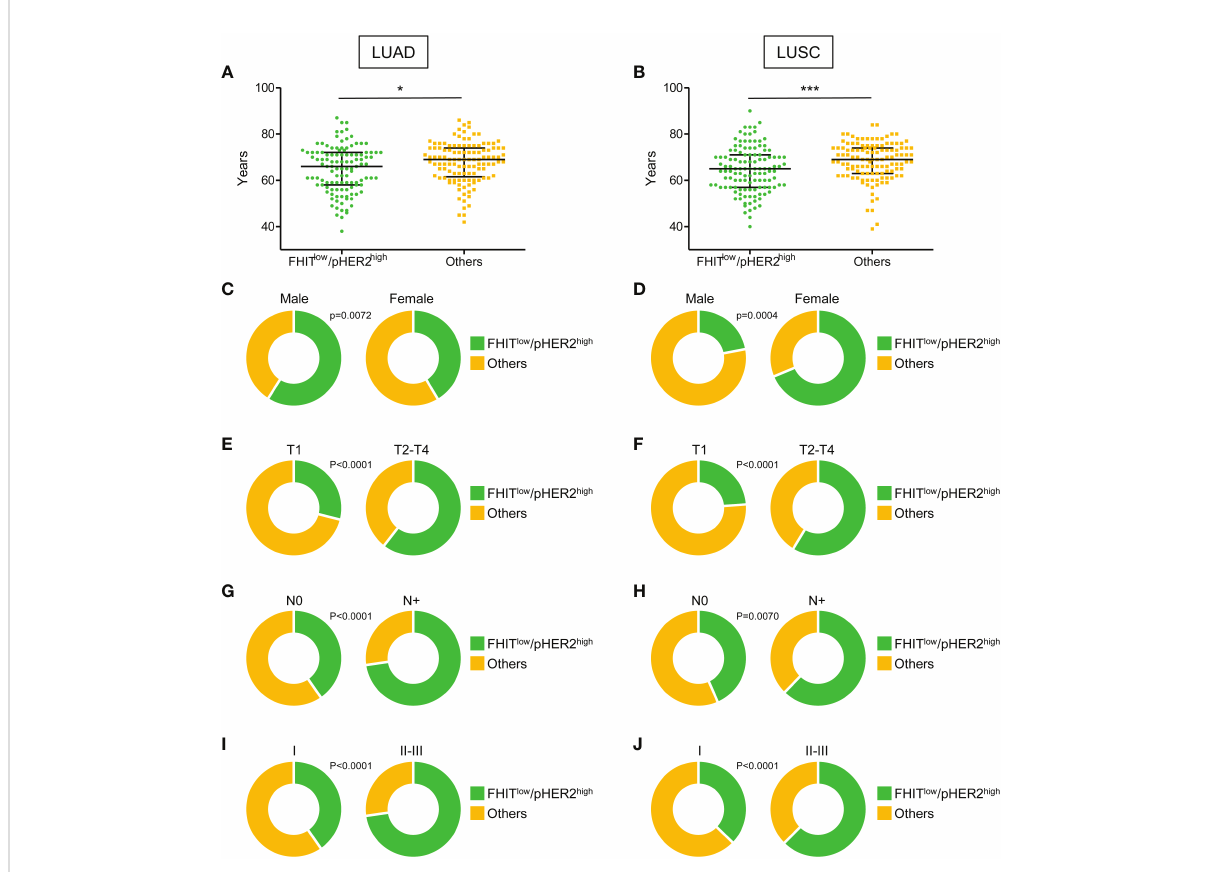
FIGURE 3 Clinical parameters associated with FHIT low /pHER2 high signature in Firehose Legacy TCGA-LUAD and TCGA-LUSC cohorts. (A, B) Distribution of the age of FHIT low /pHER2 high (in green) and other patients (in yellow) in LUAD (A) and LUSC (B) from a two-tailed Mann Whitney test. The median with 1 rst and 3 rd quartiles are shown in black. *p < 0.05; ***p < 0.001. (C-J) Distribution of the sex (C, D) , tumor size (T part of the TNM score) (E, F) , lymph node involvement (N part of the TNM score) (G, H) , and TNM stage (I, J) of FHIT low /pHER2 high (in green) and other patients (in yellow) in LUAD and LUSC, respectively (Fisher ’ s exact